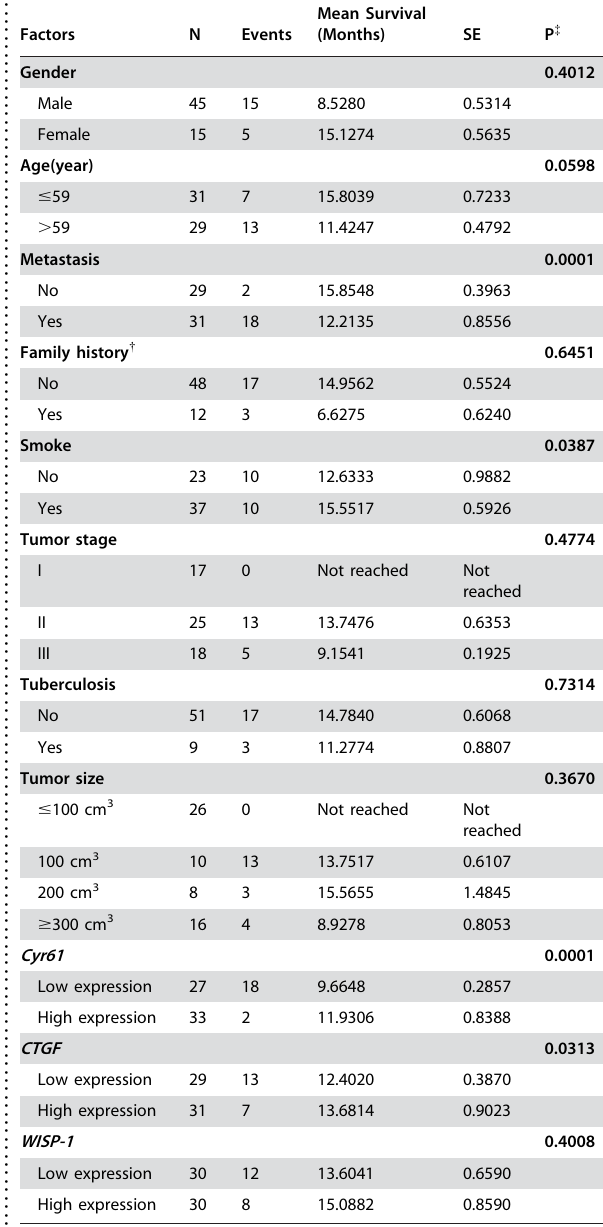
Table 5. Cox regression analysis of Cyr61 , CTGF , and